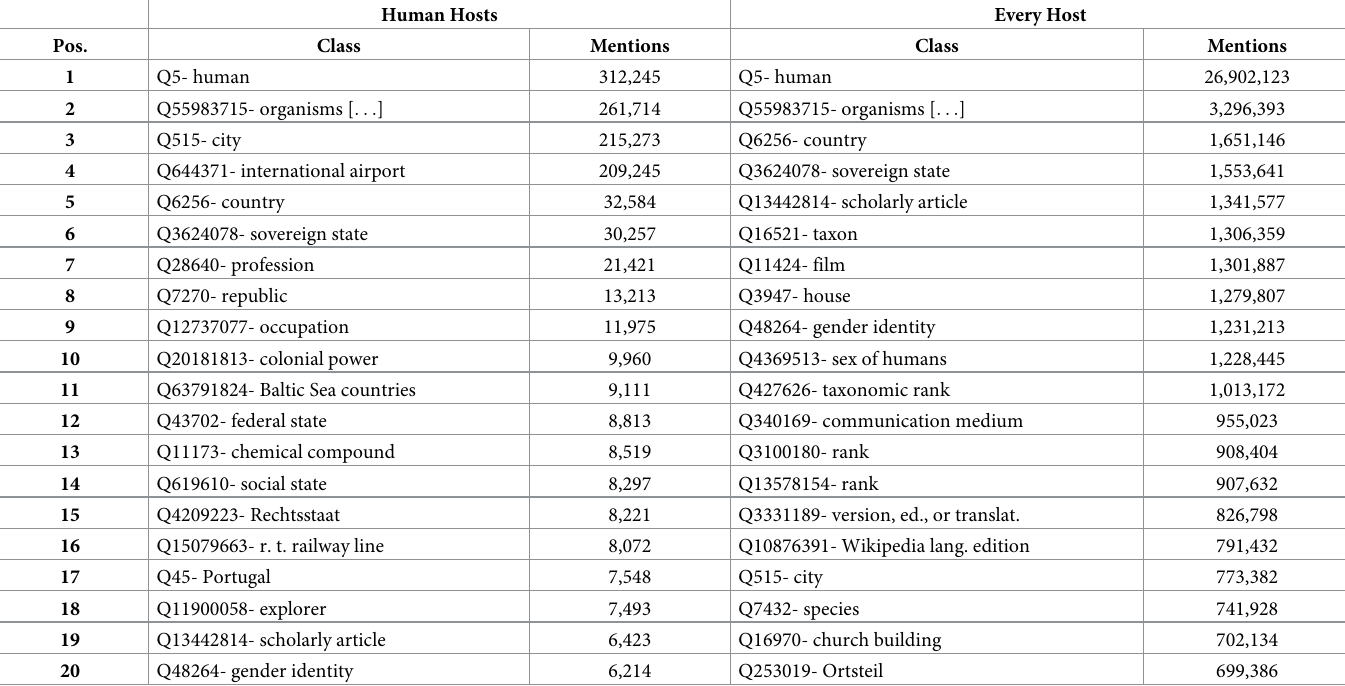
Table 5. Top20 elements for HH and EH entries in